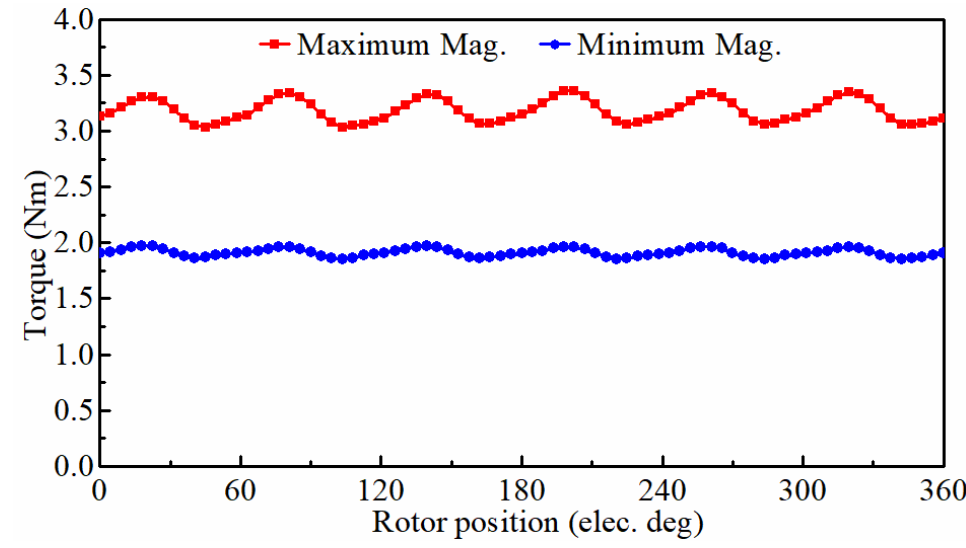
Figure 14. Electromagnetic torque waveforms at the rated current in the maximum and minimum magnetization states.